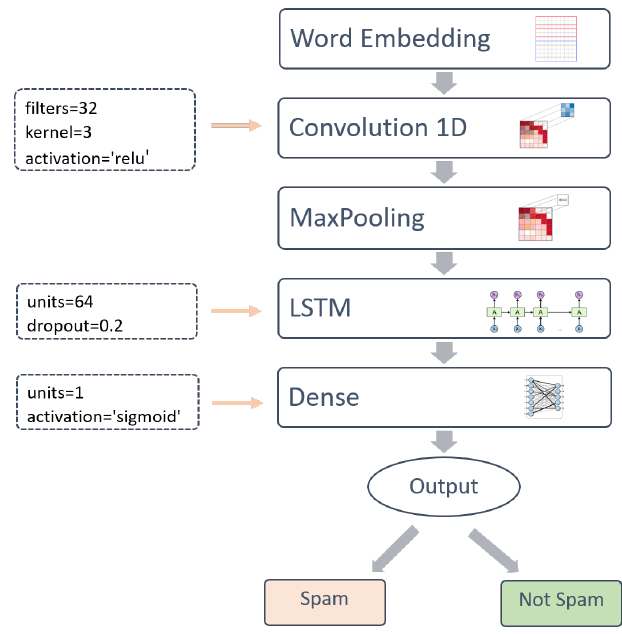
Figure 3. Architecture of the CNN-LSTM